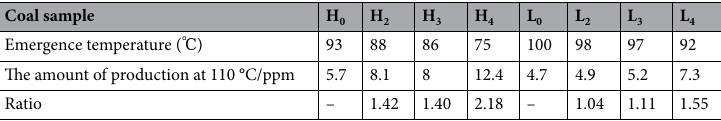
Table 3. CO generation law under low temperature oxidation of coal.